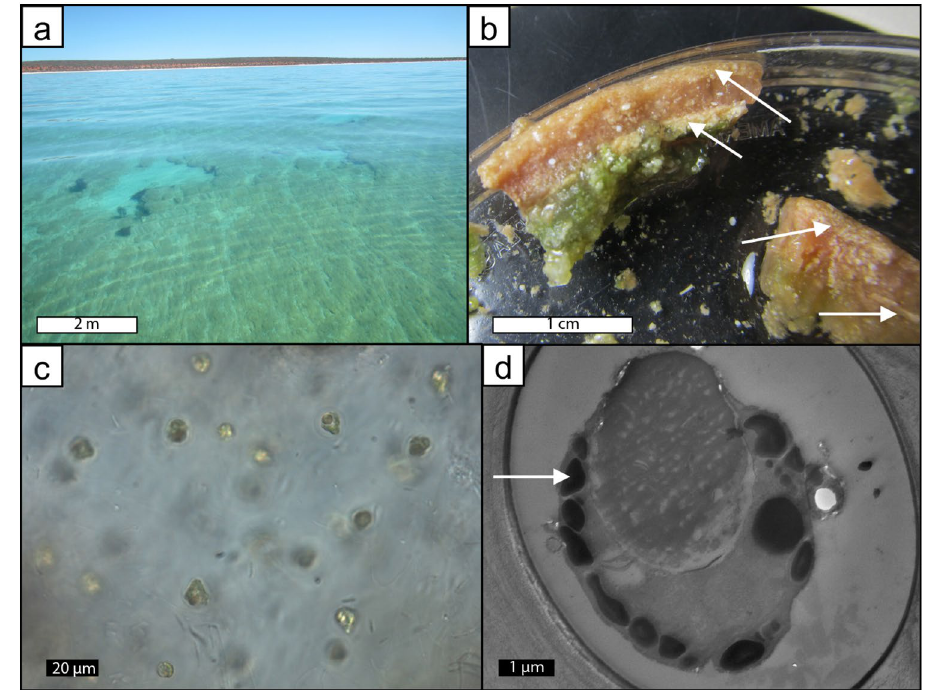
Figure 5. Irregular micritic grain production in gel mats colonizing the surface of low-relief microbial pavements. ( a ) Gel mats in the shallow subtidal zone of Hamelin Pool in the Booldah Province; ( b ) gel mat showing thin laminae of micritic calcium carbonate on the surface and as horizons within the mat (arrows), as well as within the mat; ( c ) phase contrast micrograph of the gel mat showing cells of the 10 µm in diameter microalga with conspicuous pyrenoid (phase bright spheres); ( d ) TEM image of ultrathin section of the microalga through the pyrenoid, revealing the starch granules